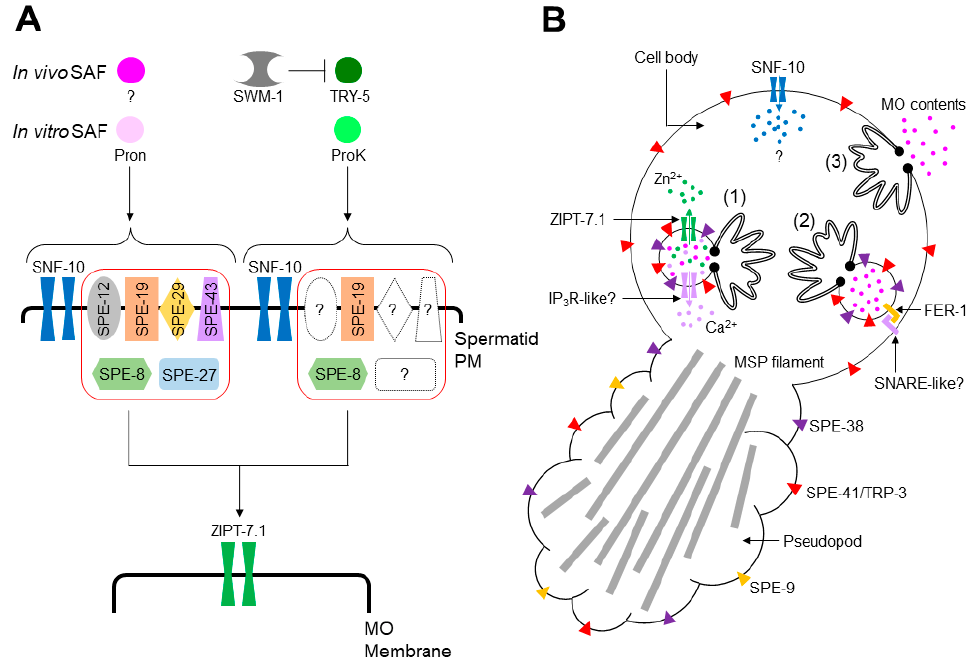
Figure 3. Summary of C. elegans spermiogenesis. ( A ) A proposed model of spermiogenesis pathways. One pathway is dependent on SPE-8 class proteins (enclosed in red box) and SNF-10 and is activated by in vivo SAF (hSAF, dark pink-colored circle) or in vitro SAF (the bacterial protease mixture Pronase (Pron), light pink-colored circle). Another pathway also depends on SNF-10 but only partially requires SPE-8 class proteins. Broken-lined symbols represent SPE-8 class proteins whose functions are not essential for this pathway. The SPE-8 class-independent pathway is possibly activated by the male-produced serine protease TRY-5 (in vivo SAF (mSAF), dark green-colored circle) or bacterial serine protease Proteinase K (ProK; in vitro SAF, light green-colored circle). In the gonads, TRY-5 and SWM-1 form a protein complex to prevent ectopic spermiogenesis. SWM-1 has two trypsin inhibitor-like domains, implying that an additional unknown serine protease might act as in vivo SAF. Two pathways indicated here would merge at a certain point, and ZIPT-7.1 presumably functions downstream of that point. ( B ) Pseudopod extension and MO fusion during spermiogenesis. The formed pseudopod contains major sperm protein (MSP) filaments (light gray-colored thick bars), which grant motility via cytoskeleton assembly and disassembly. Steps (1–3) represent the events during MO fusion. In Step (1), some colored circles show MO contents such as Zn 2+ (green), Ca 2+ (purple), and other soluble contents (pink). The blue-colored circle represents an unknown substance imported into spermatids via SNF-10. It is currently unclear where and how Ca 2+ is released into the cytoplasm, but an inositol 1,4,5-trisphosphate receptor (IP 3 R)-like protein(s) might reside on the MO membrane. In Step (2), FER-1 might associate with an unknown SNARE protein, mediating the fusion between the MO membrane and spermatid PM. After completion of MO fusion, represented by Step (3), MO contents are released extracellularly, and SPE-9 on the spermatid PM and SPE-38 and SPE-41/TRP-3 on the MO membrane are relocated to the surfaces of the pseudopod (SPE-9 and SPE-38) or entire spermatozoon (SPE-41/TRP-3). The pseudopod is where a spermatozoon interacts with an oocyte.